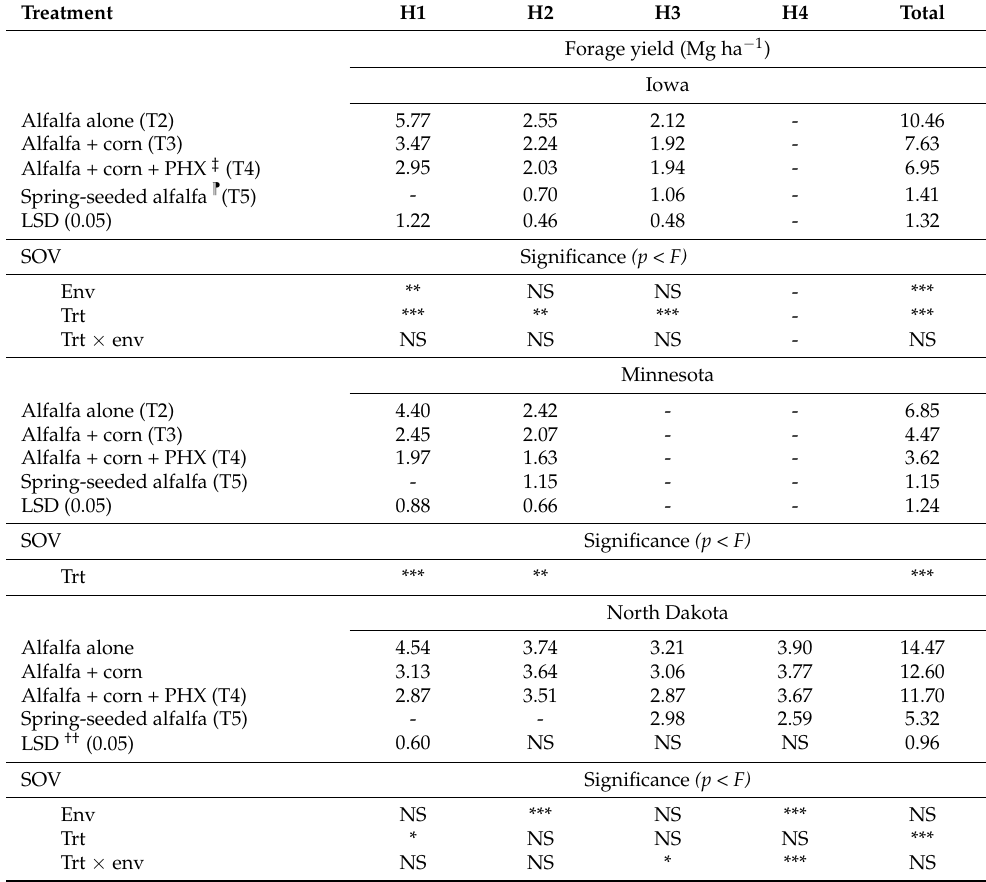
Table 7. Alfalfa forage yield in the first production year for four harvests (H1, H2, H3, and H4), and total seasonal averaged across environments (Env) within a same state † and significance of effects (source of variation, SOV) in the model. Treatment